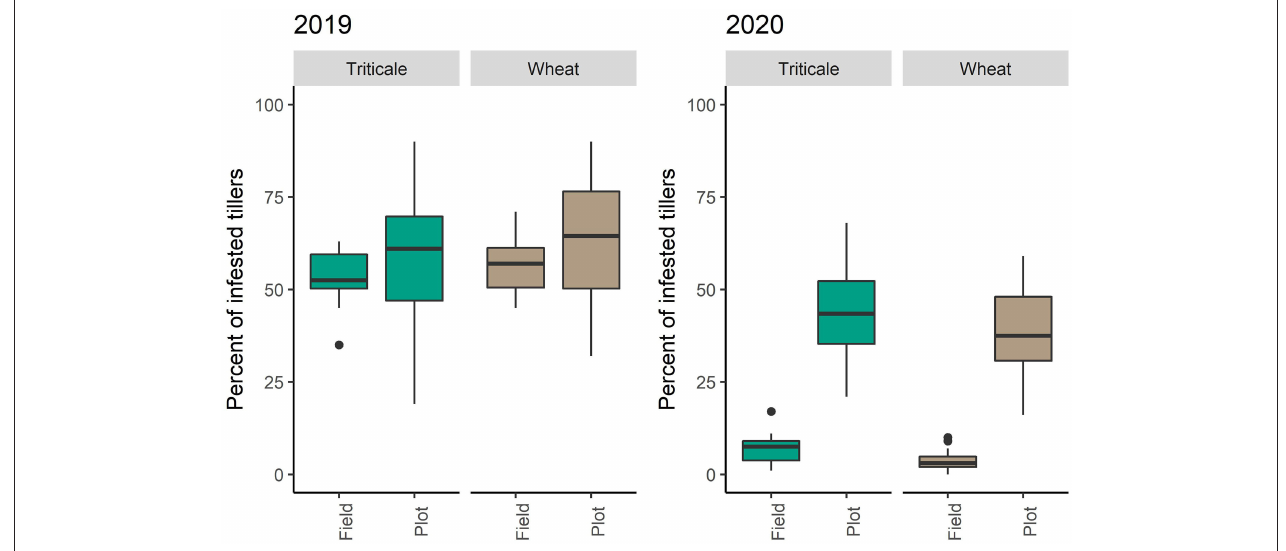
FIGURE 6 | Differences in the number of infested stems between trial plots and adjacent wheat for 2019 and